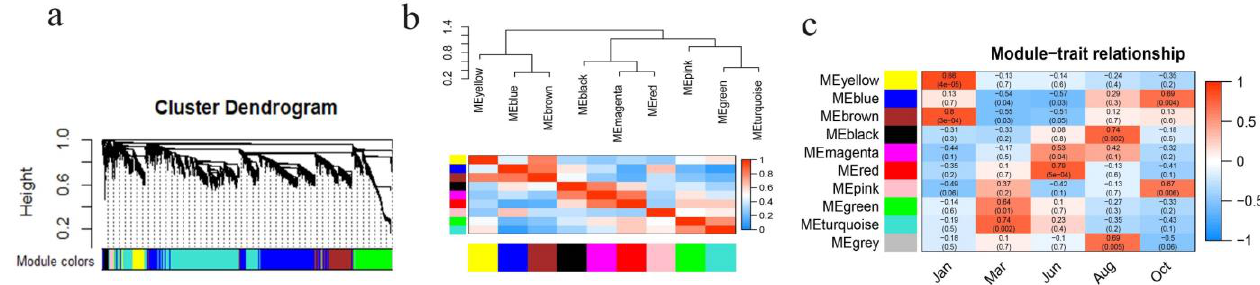
Figure 1. Construction of mRNA-lncRNA co-expression modules of yak HFs cycle based on DEMs and DELs. ( a ) Clustering dendrograms of co-expression network modules, each module was assigned a color. ( b ) The adjacency heatmap of eigengene. Below is the module clustering heatmap, above is the module clustering tree—high adjacency was shown in red, low adjacency was shown in blue. ( c ) Correlation analysis of modules and different periods of hair cycle. The upper number in the color block represents the correlation, below is the P value. Red indicates a positive correlation and blue indicates a negative correlation.